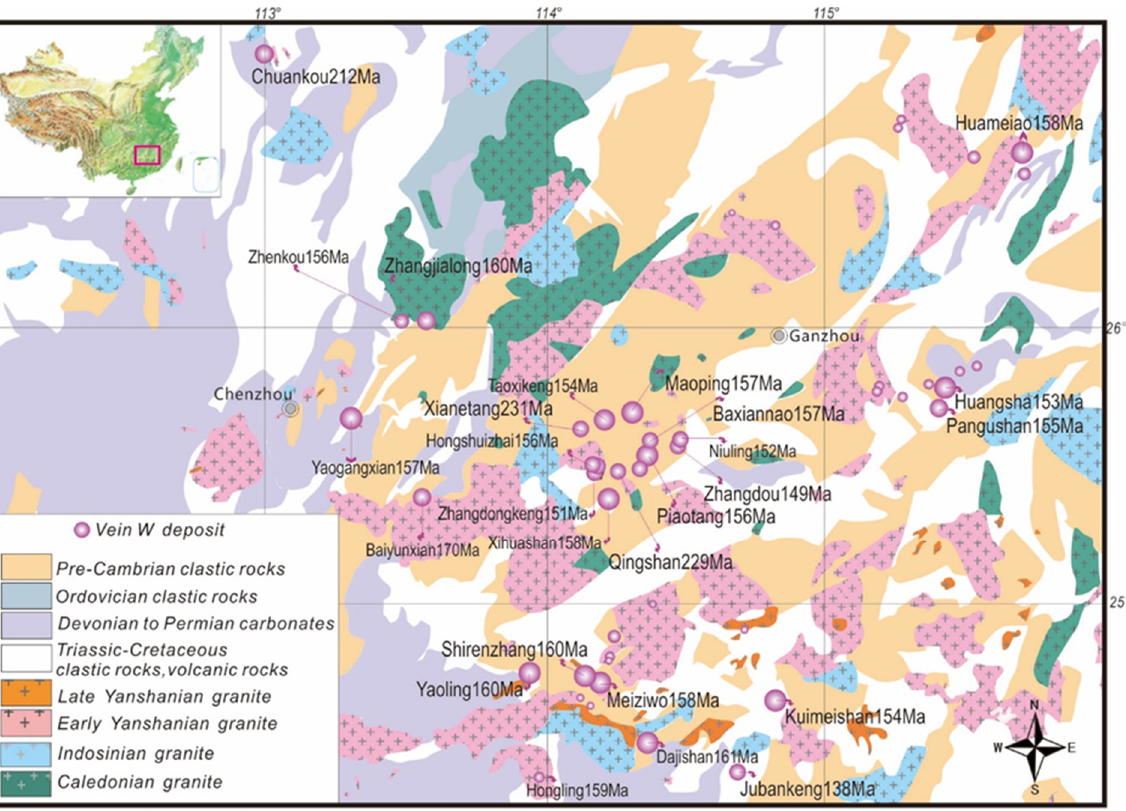
Figure 2. Simplified geologic map showing the distribution of wolframite-quartz vein tungsten de- posits in the Nanling region, South China (modified after [86]).